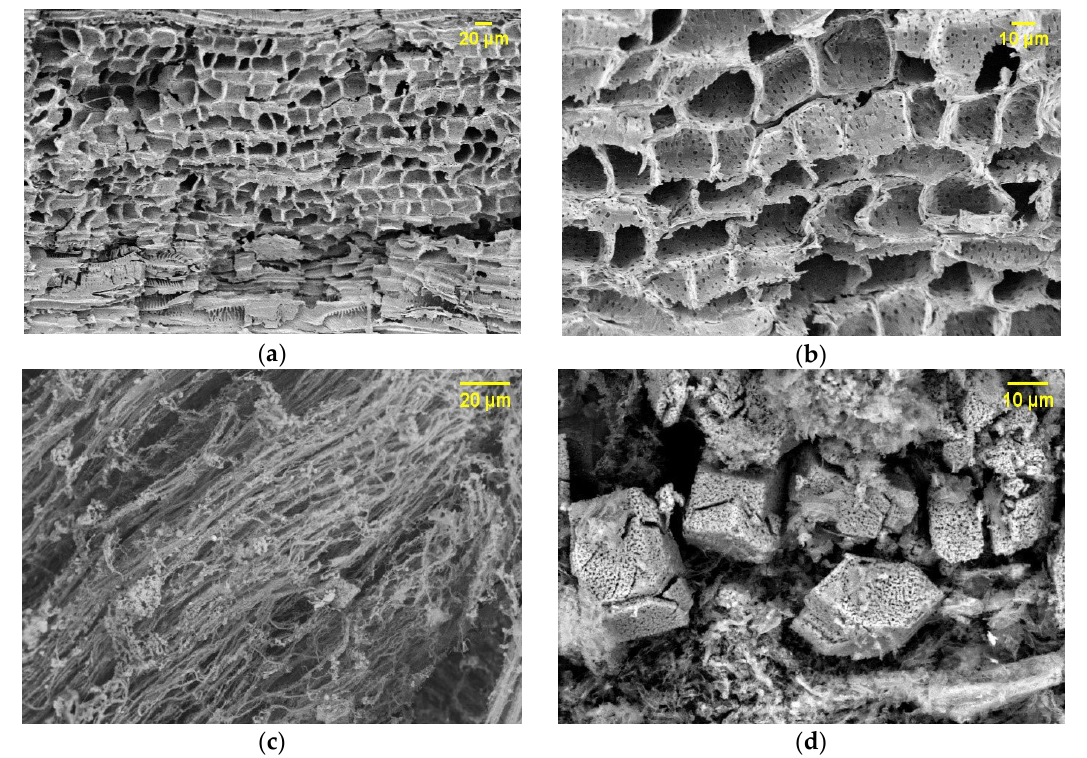
Figure 2. FE-SEM micrographs of the YM ( a – b ) and CYM ( c – d ) samples. Table 1. Specific surface area (SSA) of YM samples.